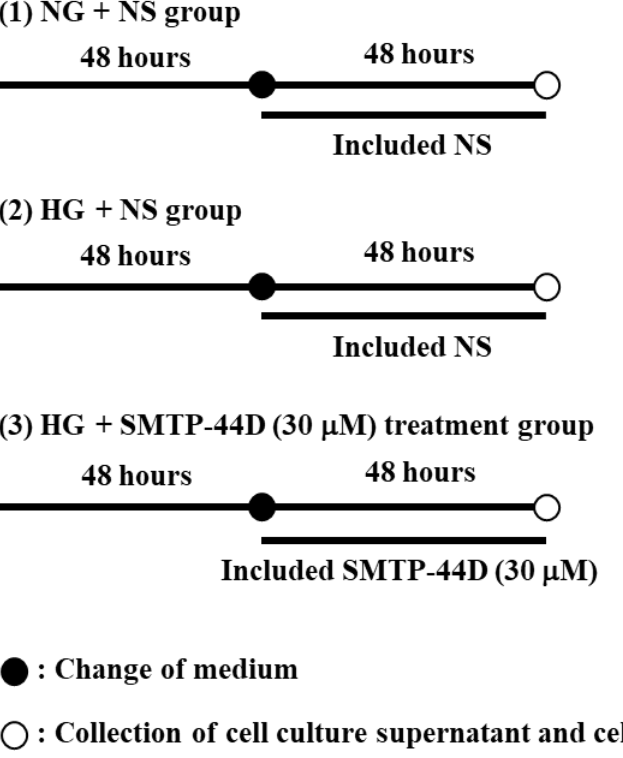
Figure 6. Schematic representation of the three different culture conditions: (1) Normal glucose (5.6 mM; NG) + normal saline (NS); (2) high glucose (30 mM; HG) + NS; (3) HG + SMTP-44D (30 μ M).